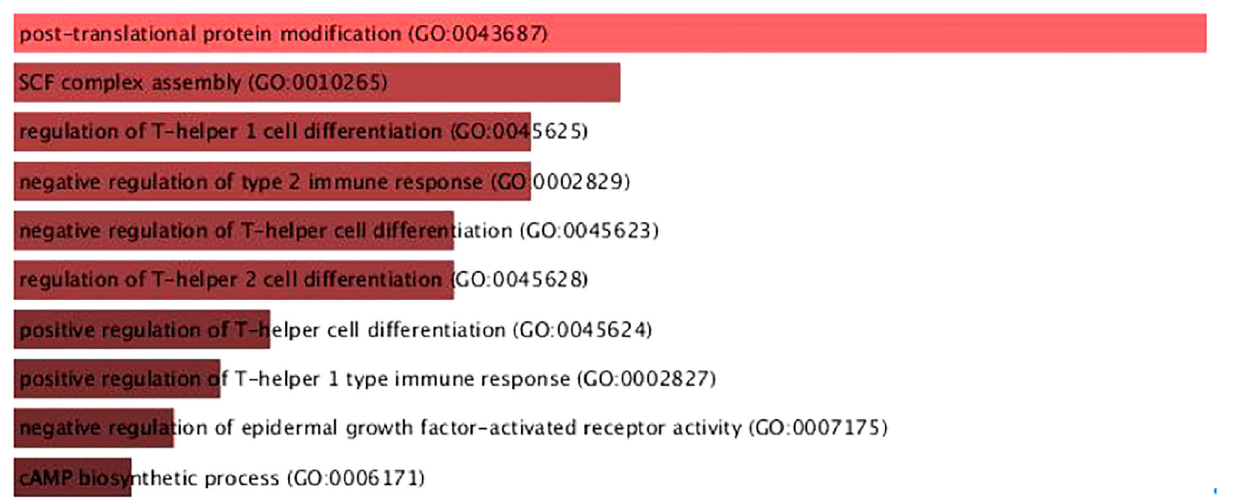
FIGURE 3 | Biological process terms of the 60 dysregulates genes in canine and human melanoma. It is possible to observe differences in processes related to immune system response. Figure generated using the online tool Enrichr [https://maayanlab.cloud/Enrichr/enrich#; (11,